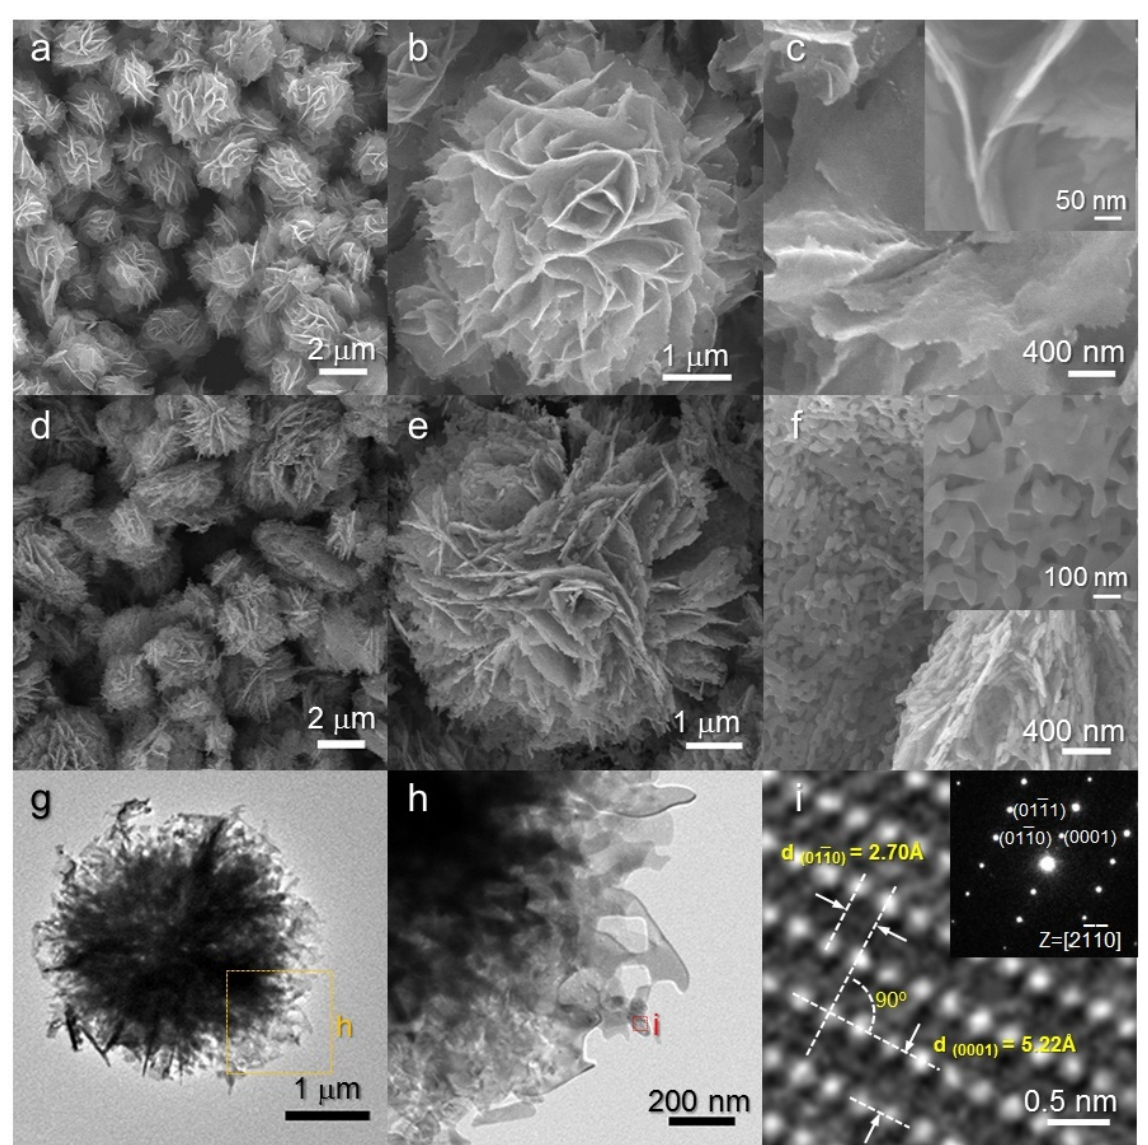
Figure 2. ( a–c ) SEM images of as-prepared H-NS precursors; ( d–f ) SEM images of heat-treated H-NS ZnO nanostructures; ( g–i ) TEM images of heat-treated H-NS ZnO